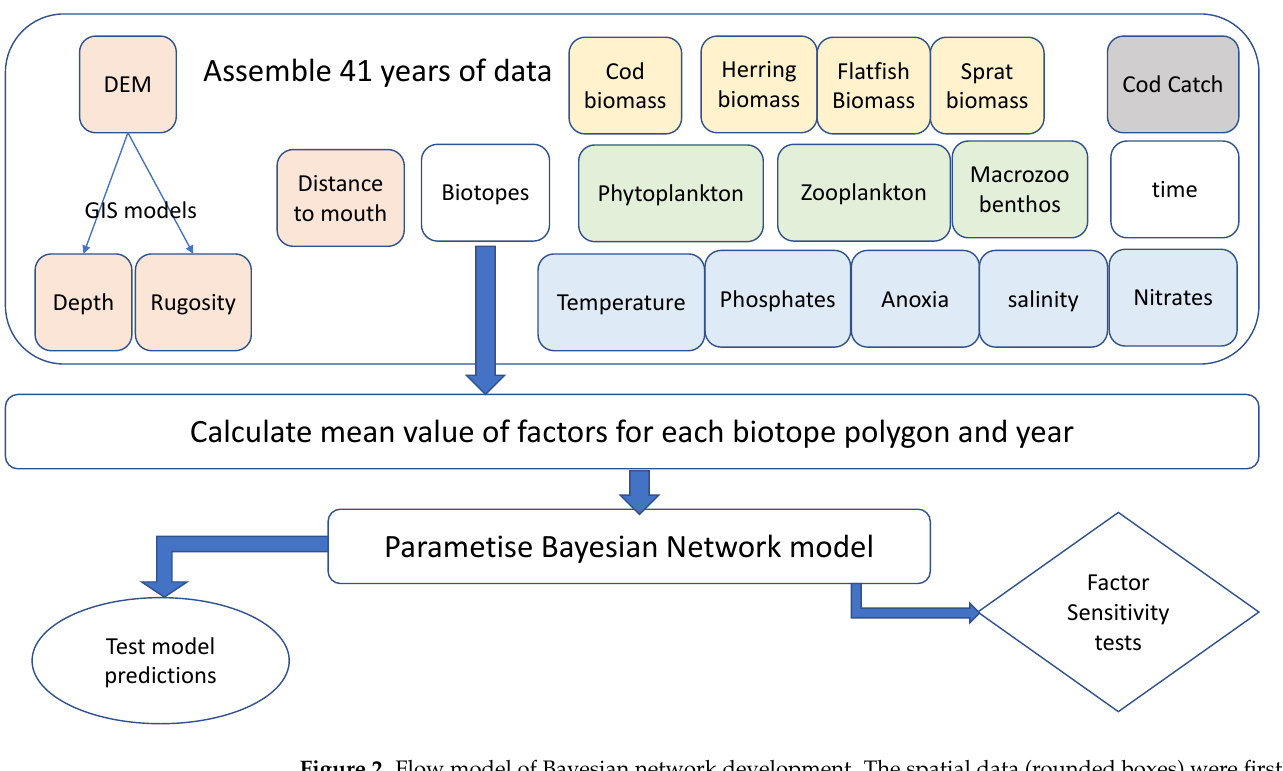
Figure 2. Flow model of Bayesian network development. The spatial data (rounded boxes) were first checked for quality across 41 years. The data were then aggregated based on the biotope polygons for every year. The BN was then parameterized from this large dataset. The model was subsequently used to make predictions with comparison to the actual observations (oval shape). The factors that make up the model were assessed in terms of sensitivity in order to understand the model influences (diamond